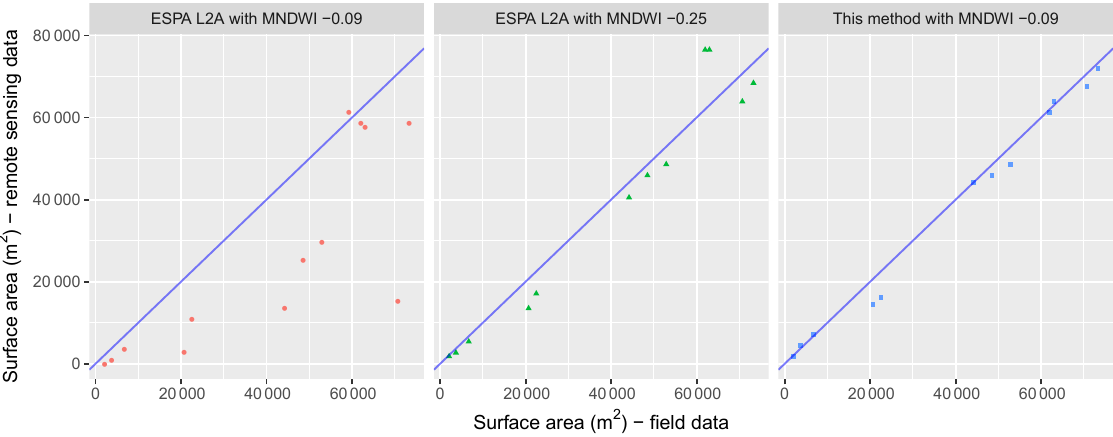
Figure 8. Remotely sensed surface areas with MNDWI on Landsat ESPA surface reflectance products and Landsat surface reflectance through our treatment chain vs. field data (13 DGPS contours) in May and June